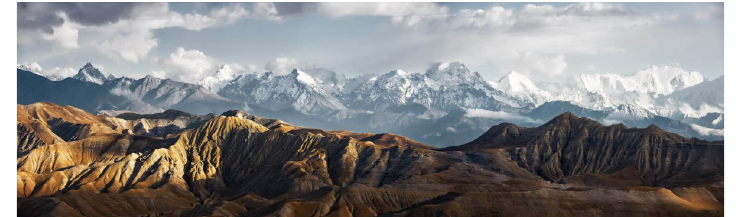
Figure 3. A fractal mountain.